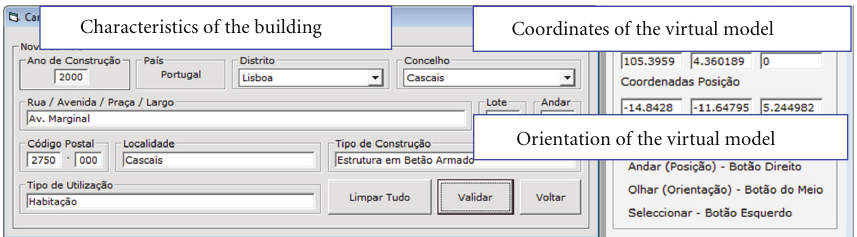
Figure 3: Interface for the detailed description of the building and coordinates and manipulation commands in the virtual model.